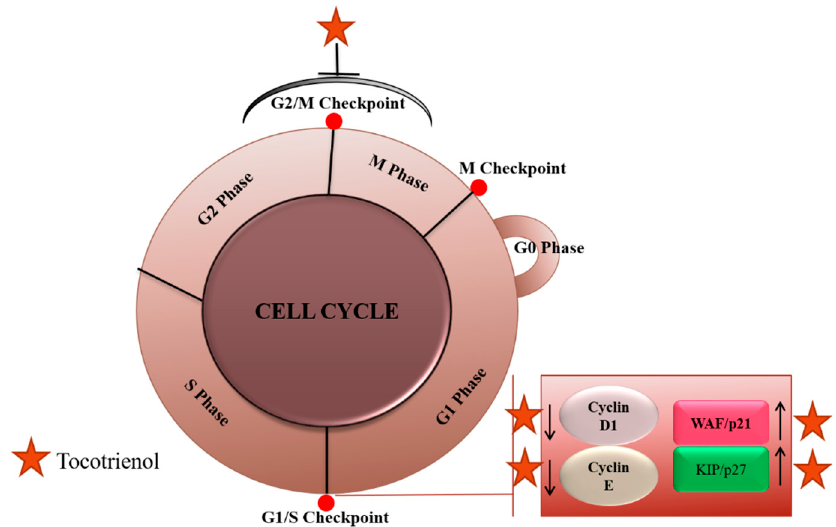
Figure 3. Tocotrienols mediated inhibition of proliferation through their effects on cell cycle regulation.